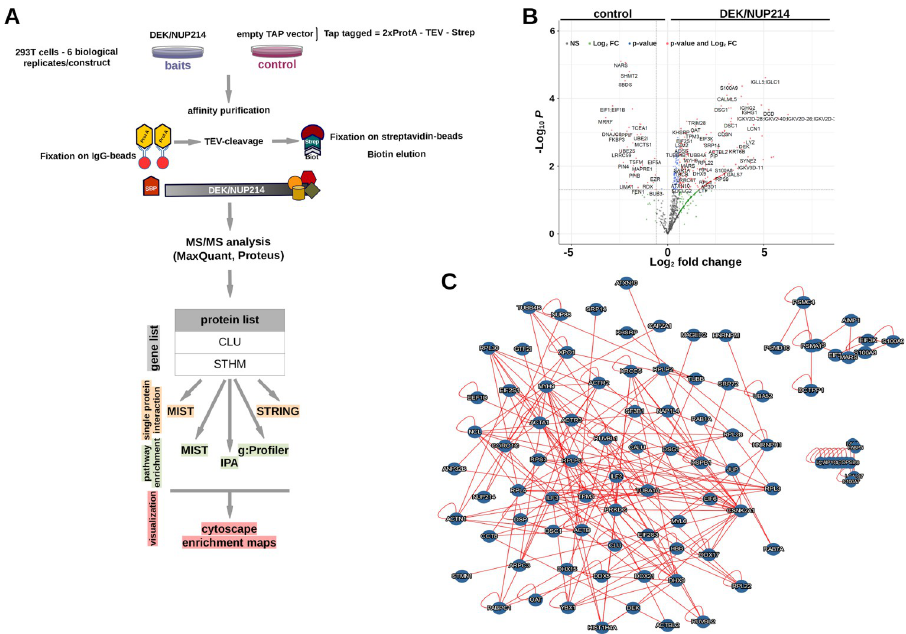
Fig 2. TAP-tag proteomics. A. TAP—Tandem Affinity Purification; TEV–Tobacco Etch Virus protease; Prot A– protein A; SBP–Streptavidin Binding Protein. Workflow of TAP-tag proteomics and Tandem MS followed by data elaboration (MaxQuant, Proteus) in combination with extended data mining by MIST, STRING, IPA, and g:Profiler. g:Profiler results were further refined and graphically elaborated in Cytoscape using the EnrichmentMap application. B. Volcano blot (Proteus) was created to distinguish DEK/NUP214 and empty vector interactomics—a synopsis of potential DEK/NUP214 interactors. C. MIST analysis of DEK/NUP214 interactors applying a threshold of Log2 fold change corresponding to an increase of interaction of 1.5-fold and a p <